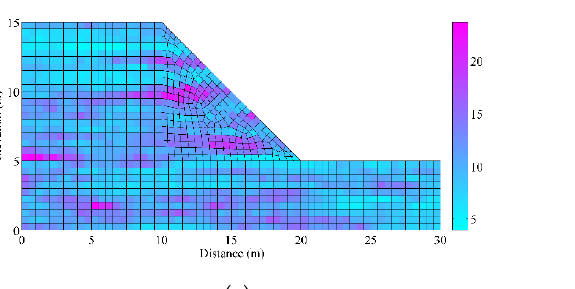
Figure 6. A typical realization of Frank copula-based transversely anisotropic CCRF. ( a ) Random field of c. ( b ) Random field of ϕ.